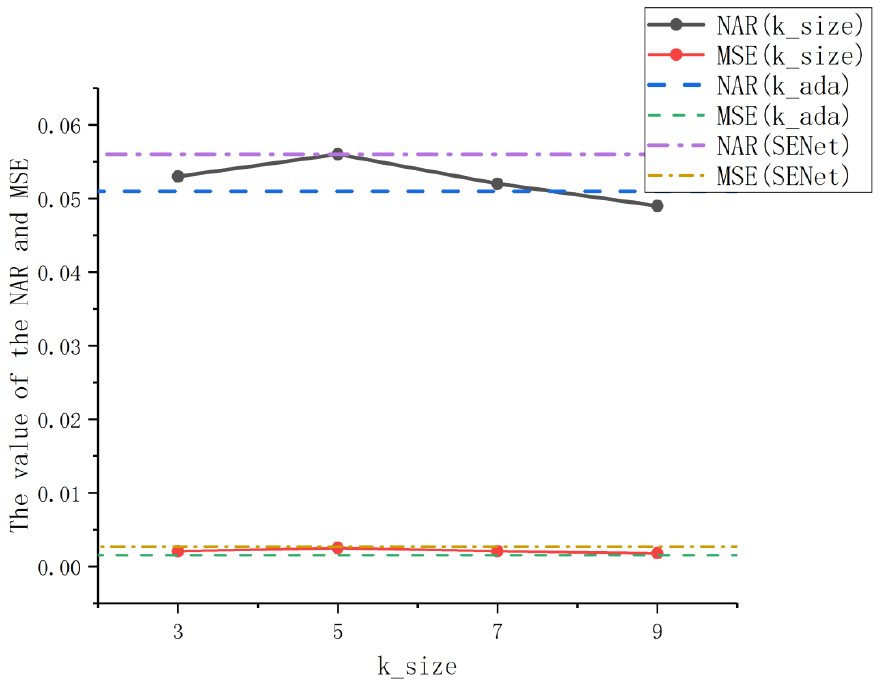
Figure 6. The performance of trademark retrieval results under different k values. NAR: Normalized Average Rank; MSE: Mean Squared Error.